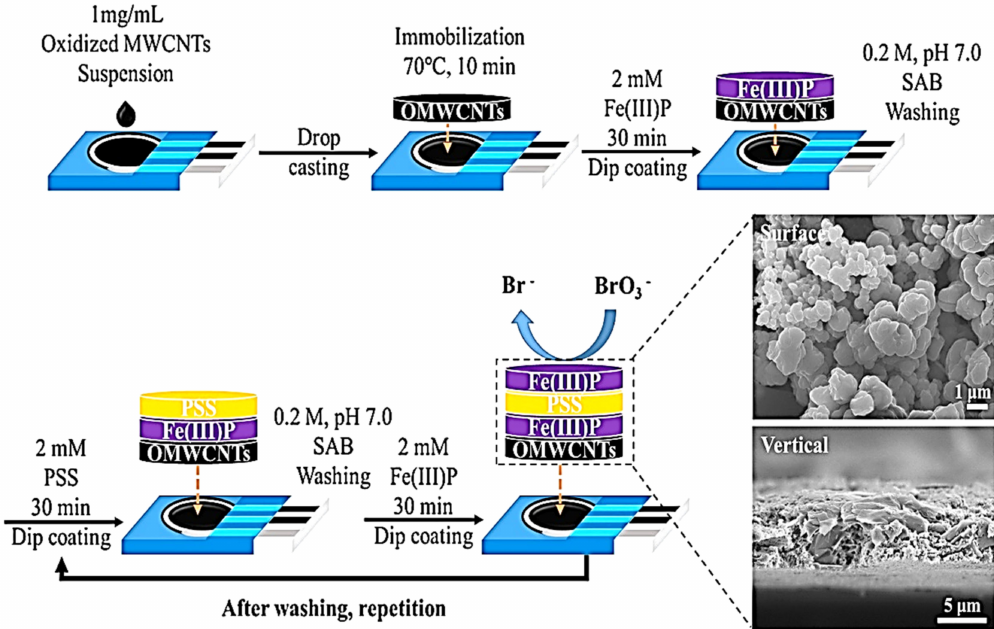
Figure 1. Schematic diagram of electrode fabrication of LBL process and FESEM images of (Fe(III)P-PSS)n-Fe(III)P- OMWCNTs/SPCE (adapted from [21] with